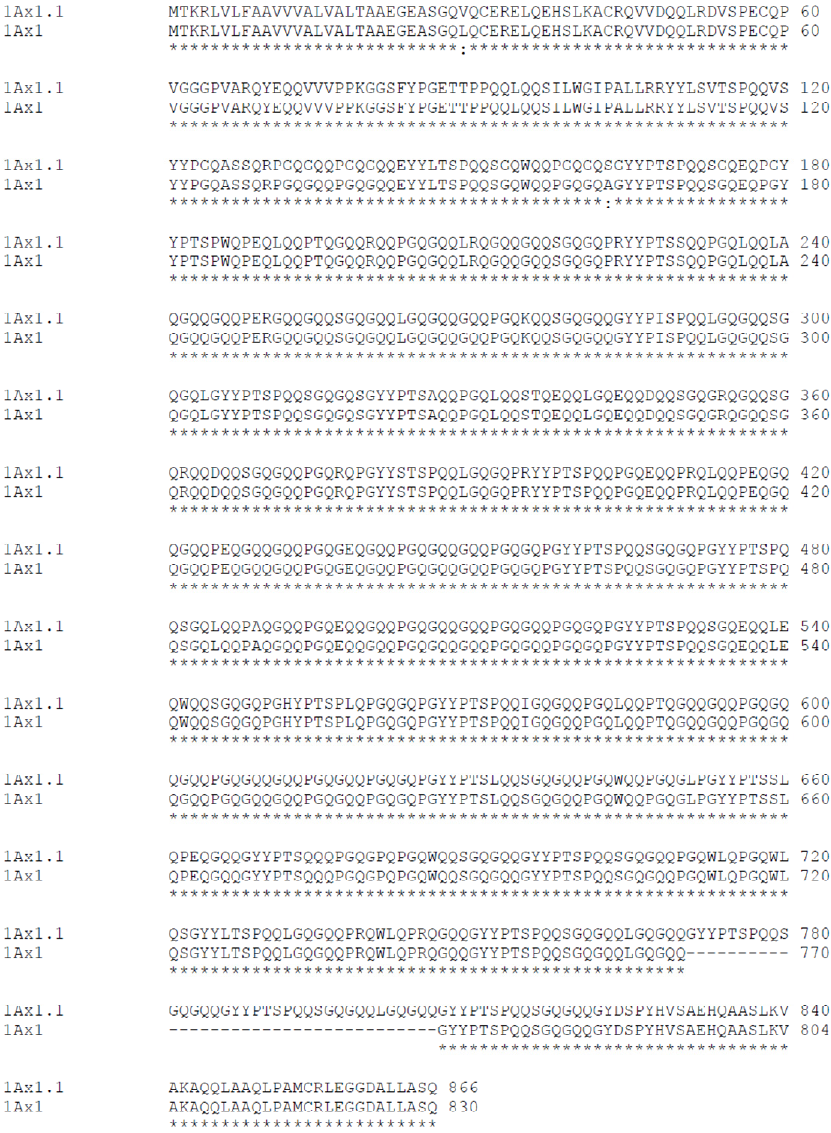
Figure 6. Alignment of the predicted primary structure of 1Ax1.1 and 1Ax1 HMW-GS. The dashes indicate the deletion of 36 amino acids at the end of the central repetitive domain at position +771 relative to the 1Ax1.1 sequence. Substitutions are indicated by